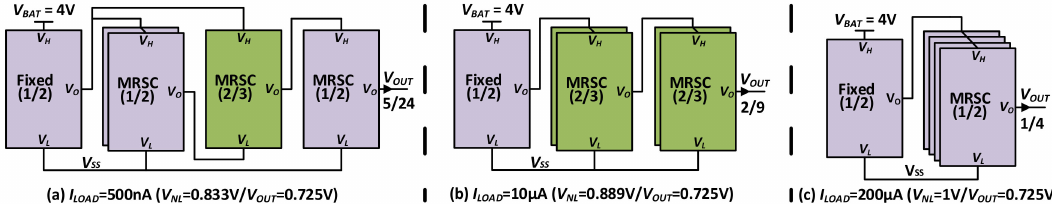
Figure 12. Optimal configuration for various load conditions when target V OUT = 0.725 V from V BAT = 4.0 V.